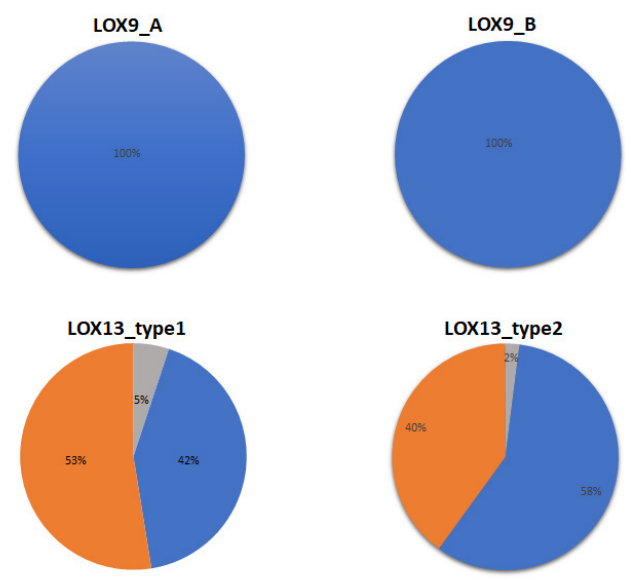
Figure 4. Subcellular localization of LOX proteins (in %). Proteins with cytoplasmic localization are represented in blue, proteins with signal peptide targeting chloroplasts are represented in orange, and proteins directed to other compartments are represented in gray.